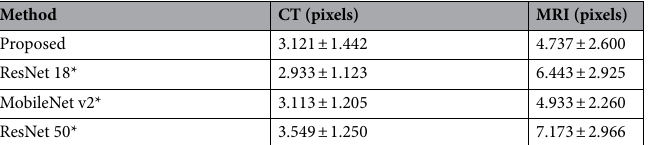
Table 5. Results summary with the mean ± standard deviation for the Hausdorff distance for the CT and MRI datasets. The values represent the final ensemble deep learning model and are based on majority voting. Models with an asterisk (*) are based on a DeepLab v3 + convolutional neural network for semantic image segmentation with a specific pretrained model.